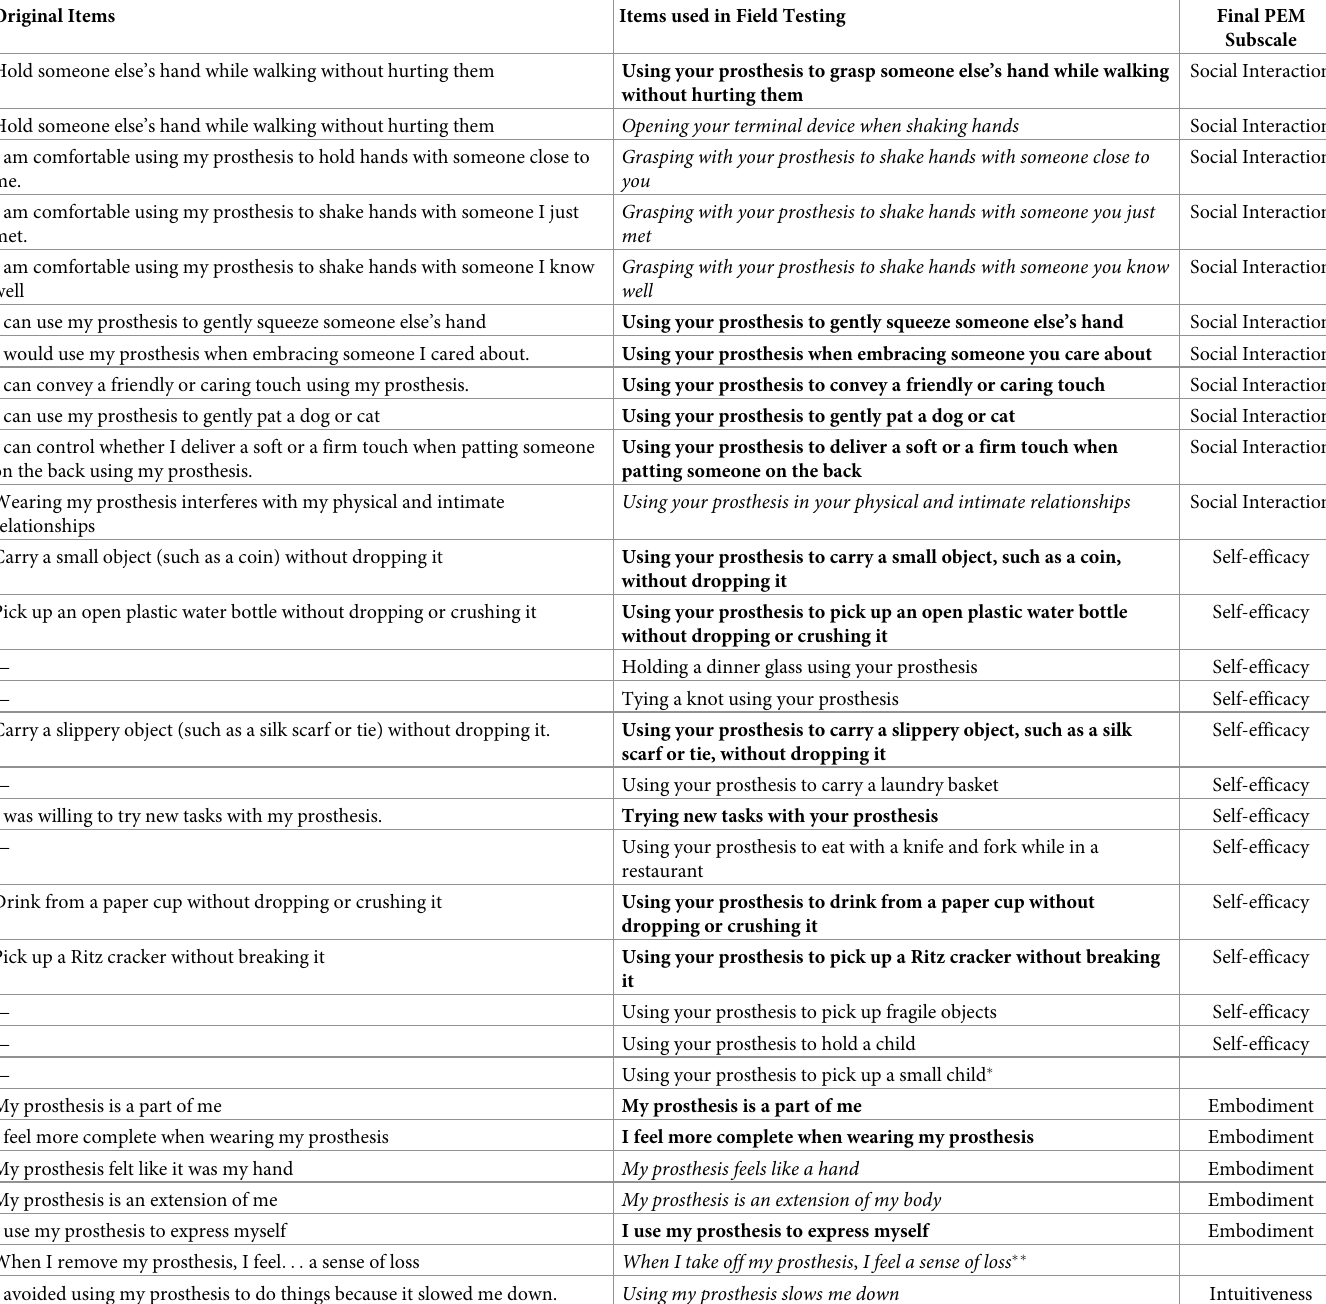
Table 3. Original PEM items, items utilized in field testing, items not retained and items in the final modified PEM. Original